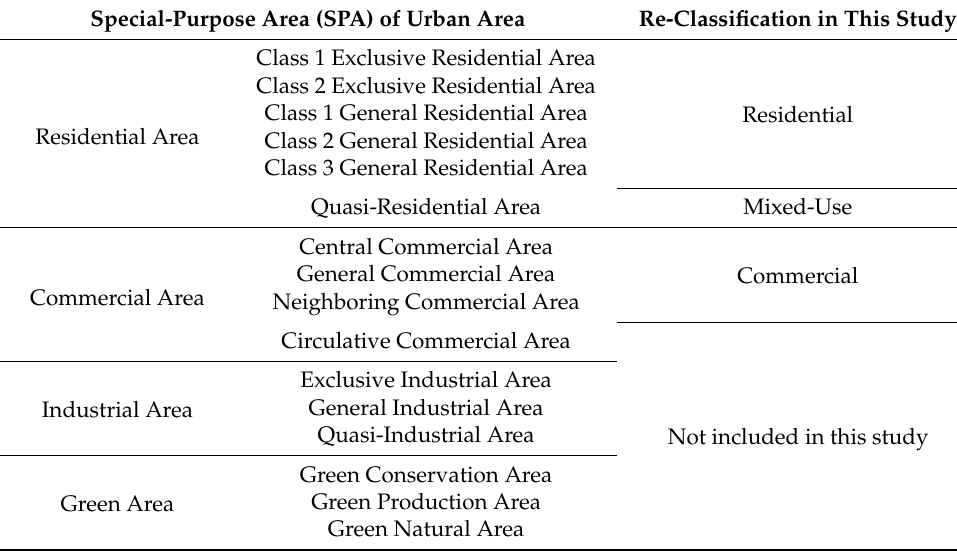
Table 1. Land-use zoning system of the urban area in